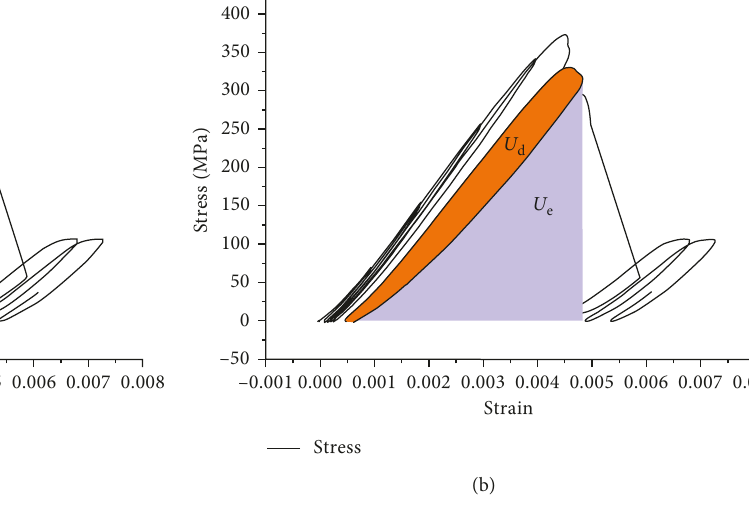
Figure 2: A diagram of the elastic energy